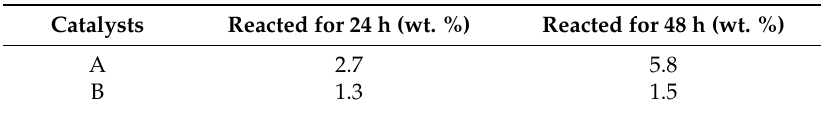
Table 2. Weight loss of thermogravimetric (TG) analysis at 200–600 °C for spent catalysts after SCR of NO in gas containing SO 2 and water vapor.